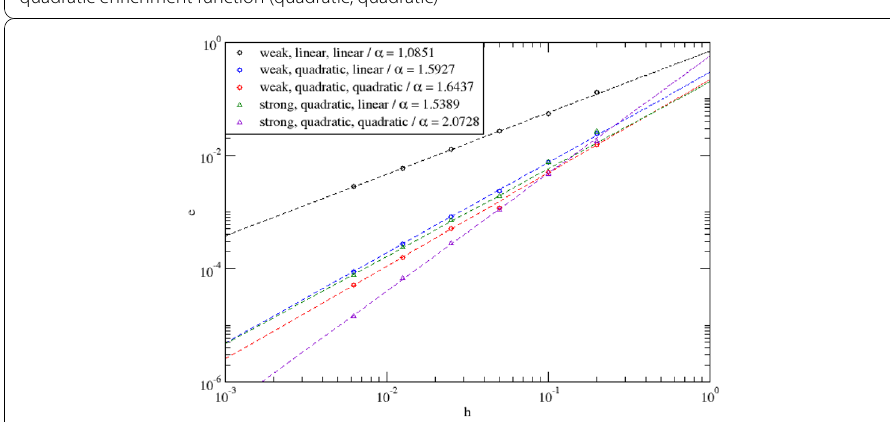
Fig. 41 Convergence rates on the relative error in terms of the energy for the volumic load problem. The enrichment strategies are: linear shape functions and linear enrichment function (linear, linear), quadratic shape functions and a linear enrichment function (quadratic, linear) and quadratic shape functions and a quadratic enrichment function (quadratic, quadratic)